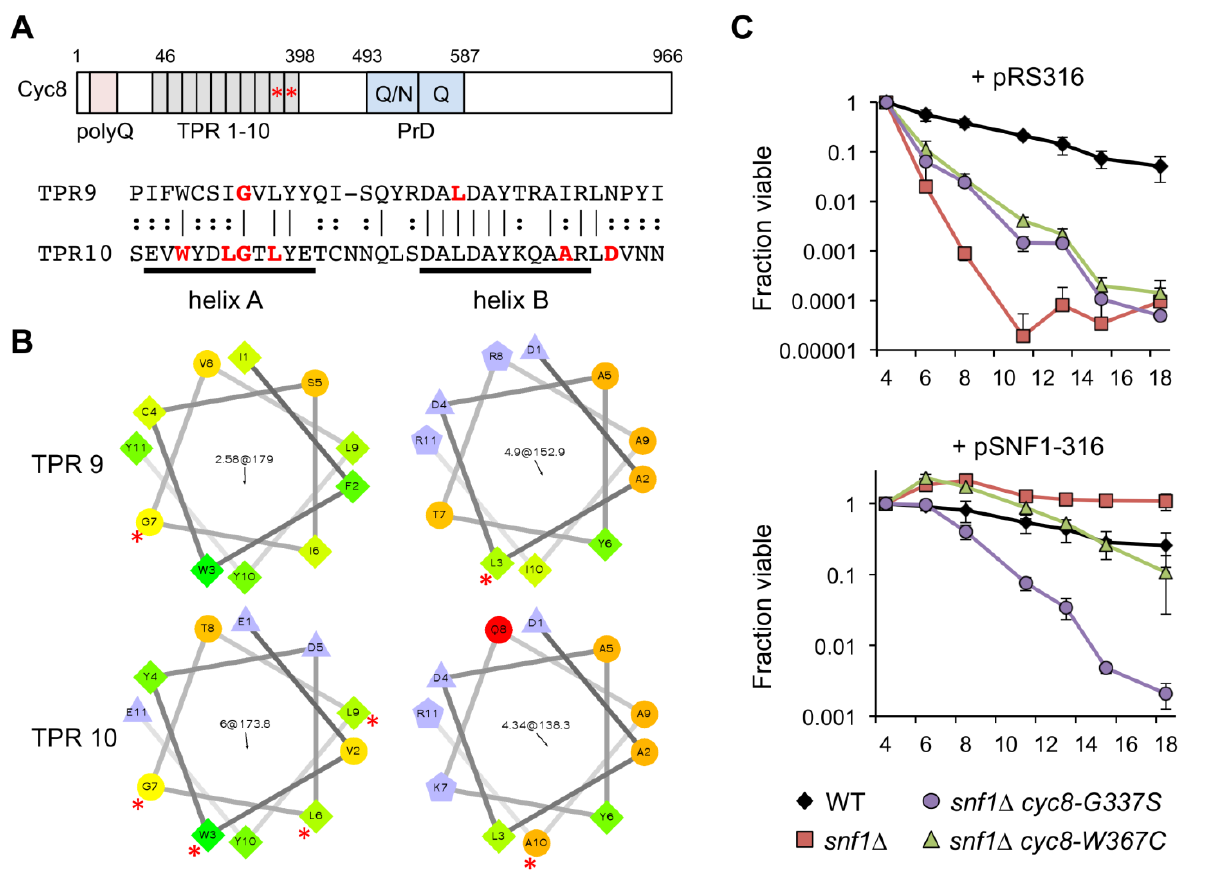
FIGURE 5: Adaptive Cyc8 mutations are specific to the TPR9 and TPR10 motifs. (A) Domain organization of the Cyc8 protein, indicating an N-terminal poly-glutamine (polyQ) tract, an array of 10 TPR motifs from amino acids 46 to 398, and the prion domain (PrD) consisting of polyQ/N and polyQ repeats. Asterisks indicate the location of mutations in the TPR9 and TPR10 motifs. An alignment of the TPR9 and TPR10 motifs is shown, indicating amino acids that were changed in the adapted strains. Note the mutations are distributed across the characteris- tic amphipathic α-helices. (B) Helical wheel representation of the A and B α-helices of TPR9 and TPR10 generated online (http://rzlab.ucr.edu/scripts/wheel/wheel.cgi). Mutated residues are indicated by an asterisk. (C) Quantitative CLS when SNF1 is restored to a cyc8 TPR9 mutant (JS1416, snf1 ∆ cyc8-G337S ) or a cyc8 TPR10 mutant (JS1417, snf1 ∆ cyc8-W367C ) by transformation with a CEN-ARS URA3 plasmid containing the SNF1 gene (pSNF1-316). The empty URA3 vector (pRS316) was also transformed as a control. Cells were main- tained in SC-ura medium with 2% glucose throughout the experiment. Error bars indicate standard